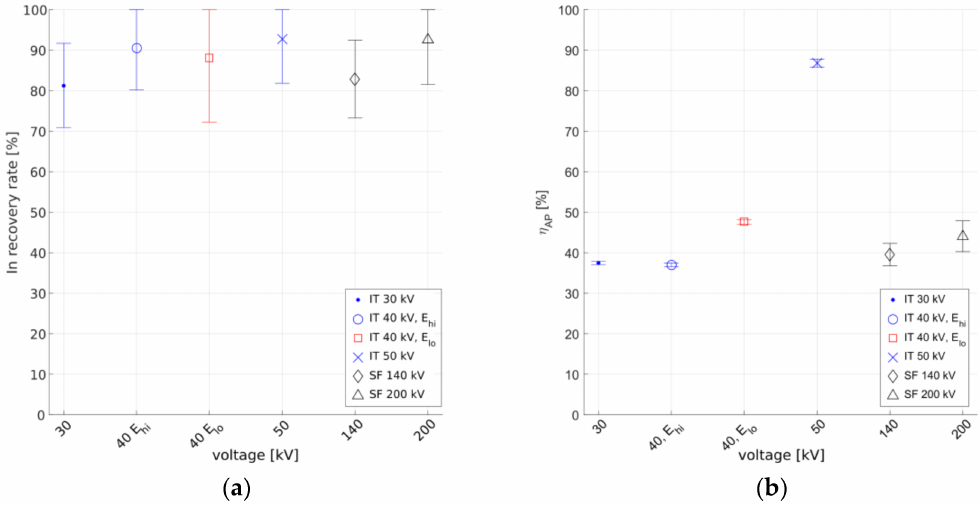
Figure 10. Values of individual test series with respect to: ( a ) Indium recovery rate and; ( b ) Pulse efficiency ( η AP